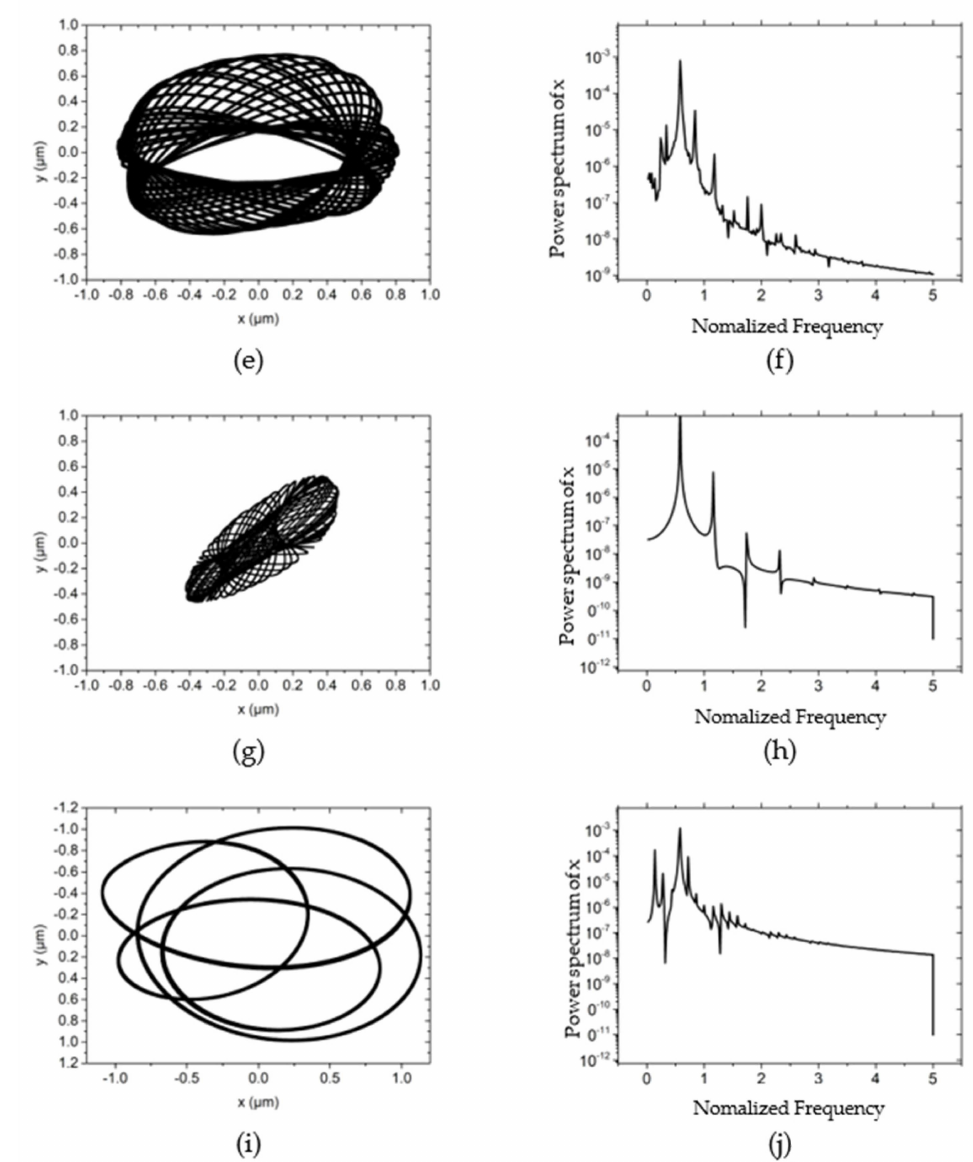
Figure 10. The influence of different rotor mass on rotor trajectory and power spectral density at Fy = 30 N, m u = 0.01 g, m = 90 g. ( a ) Rotor center trajectory ( w = 10,000 r/min), ( b ) Power spec- tral density in the x direction ( w = 10,000 r/min), ( c ) Rotor center trajectory ( w = 30,000 r/min), ( d ) Power spectral density in the x direction ( w = 30,000 r/min), ( e ) Rotor center trajectory ( w = 40,000 r/min), ( f ) Power spectral density in the x direction ( w = 40,000 r/min), ( g ) Rotor center trajectory ( w = 90,000 r/min), ( h ) Power spectral density in the x direction ( w = 90,000 r/min), ( i ) Rotor center trajectory ( w = 140,000 r/min), ( j ) Power spectral density in the x direction ( w = 140,000